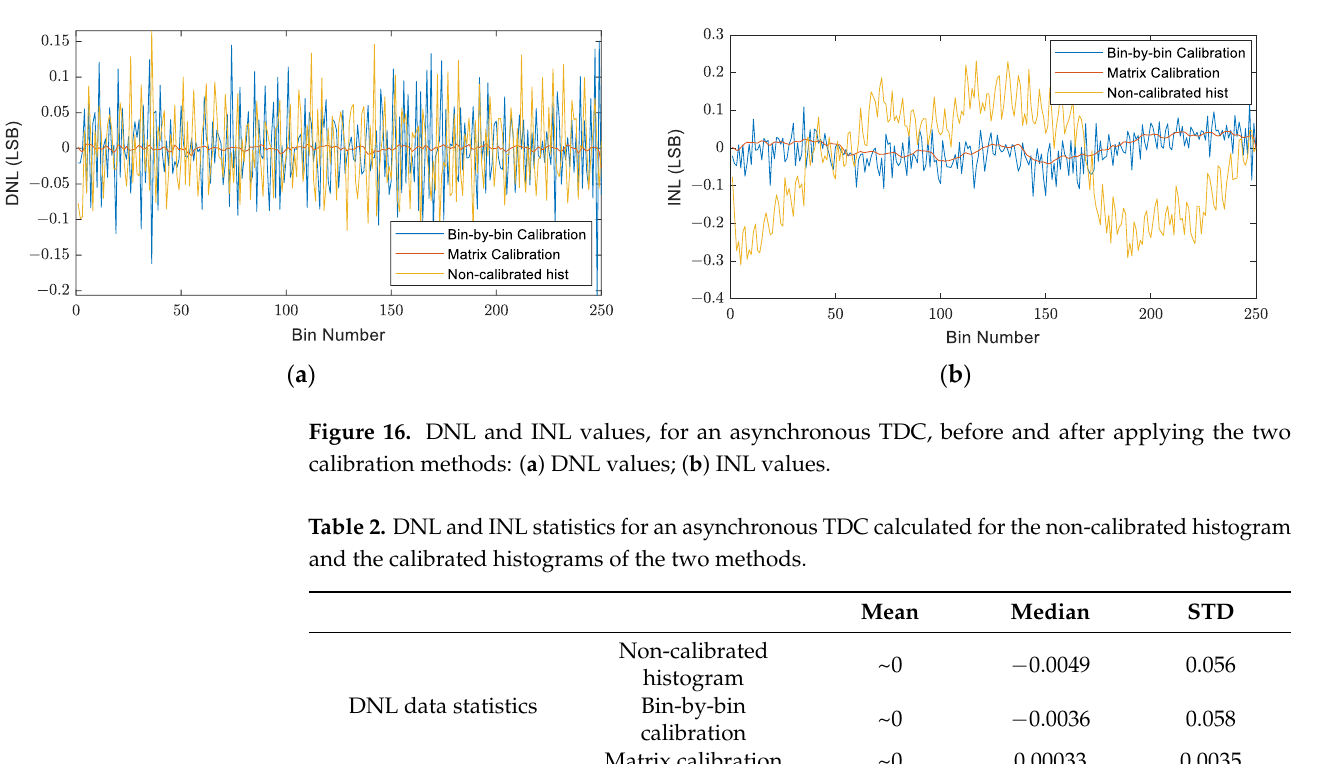
Figure 15. Simulation and experimental results for asynchronous TDCs: the DNL after applying the calibration methods compared to the DNL of the raw TDC.